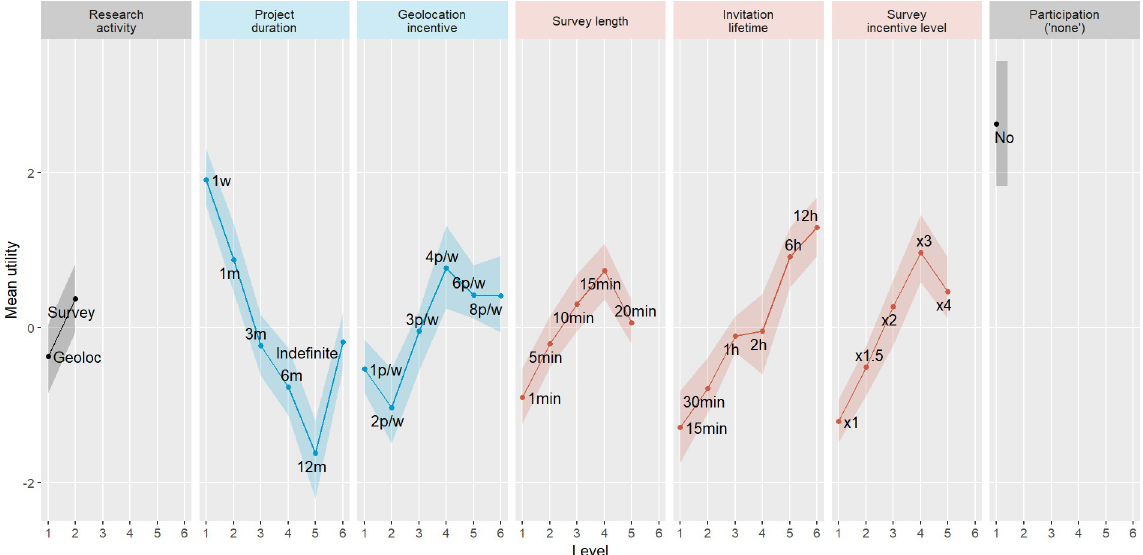
Fig 2. Mean utilities per attribute level and 95% credibility intervals (shadowed bands). Note: Blue subplots = common attributes for both geolocation-based activities; red subplots = specific in-the-moment surveys’ attributes. Grey subplots = rest of the attributes needed to model participants’